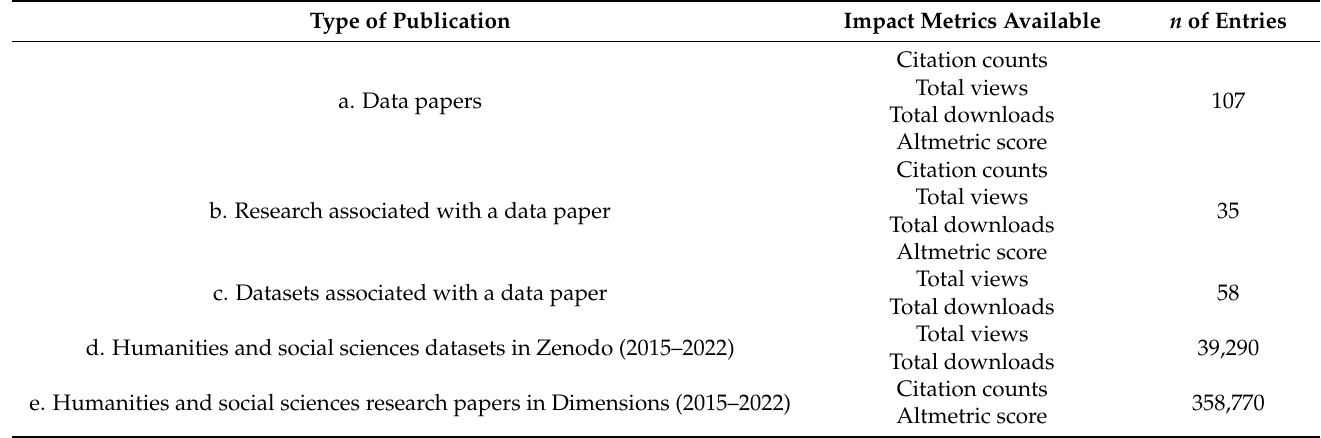
Table 4. Summary of the types of publications and respective impact metrics used in the